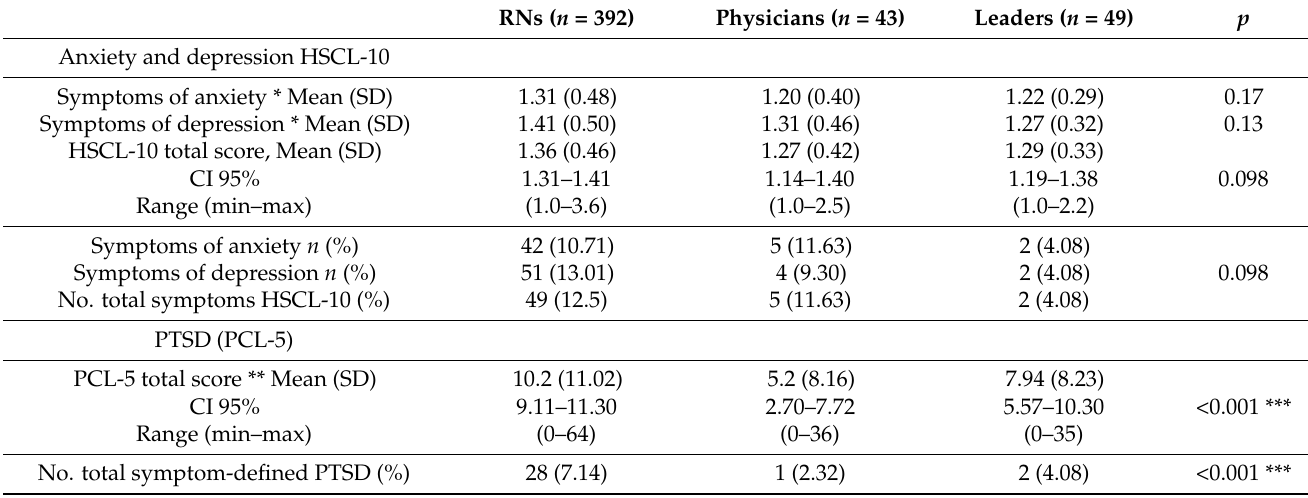
Table 2. Symptoms of anxiety and depression in health care professionals using the Hopkins Symp- tom Checklist-10 (HSCL-10) during the past week and symptom-defined PTSD (PCL-5) during the past month (N = 484). RNs ( n =